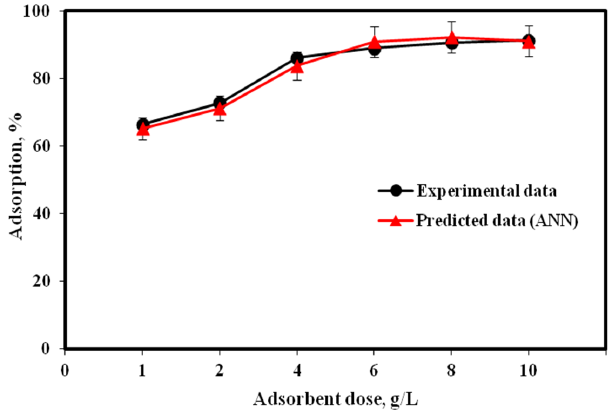
Figure 4. Influence of RHC4 dose on adsorption (Cu(II) concentration: 80 mg / L, contact time: 120 min, temperature: 22 °C, volume of solution: 100 mL).